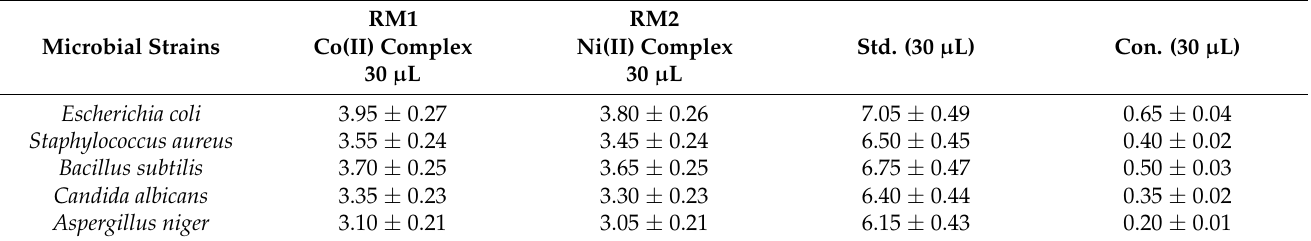
Table 3. In vitro anti-inflammatory (egg albumin) activity of our samples.